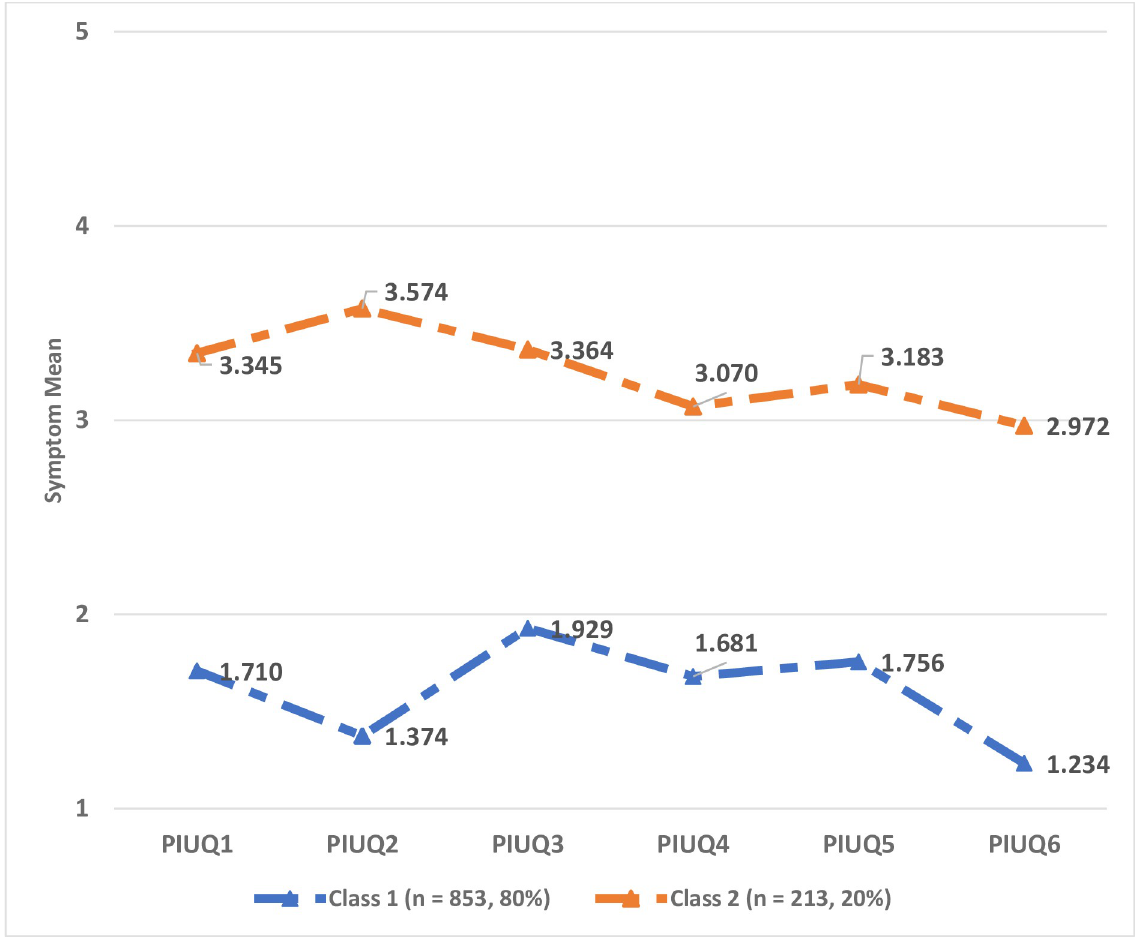
Fig 1. Characterization of the two latent classes of problematic internet users obtained from the Latent Profile Analysis (N = 1,066). Note . Problematic internet use symptom means for each item of the Problematic Internet Use Questionnaire Short-Form (PIUQ-SF-6). PIUQ1 = How often do you spend time online when you’d rather sleep ?, PIUQ2 = How often do you feel tense , irritated , or stressed if you cannot use the Internet for as long as you want to ?; PIUQ3 = How often does it happen that you wish to decrease the amount of time spent online but you do not succeed ?; PIUQ4 = How often do you try to conceal the amount of time spent online ?; PIUQ5 = How often do people in your life complain about you spending too much time online ?; PIUQ6 = How often does it happen to you that you feel depressed , moody , or nervous when you are not on the Internet and these feelings stop once you are back online ?.